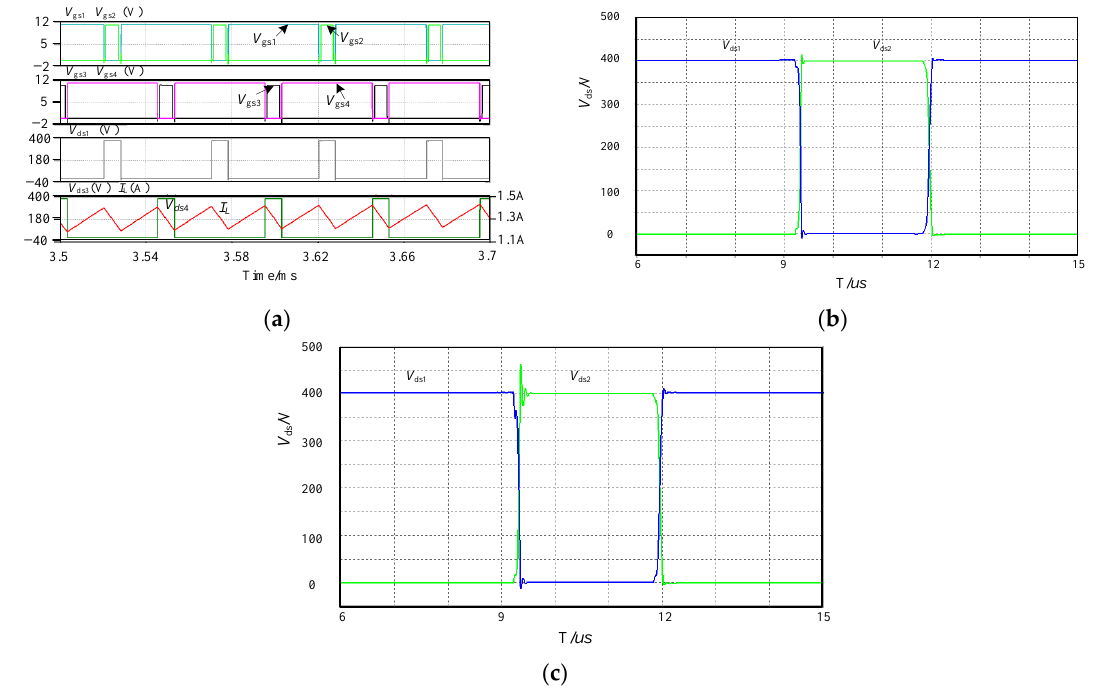
Figure 6. Simulation results of the cascode GaN HEMT-based single-phase inverter. ( a ) Waveforms of cascode GaN HEMT-based inverter; ( b ) Voltage spike of GaN HEMT with L S = 5 nH; ( c ) Voltage spike of GaN HEMT with L S = 20 nH.